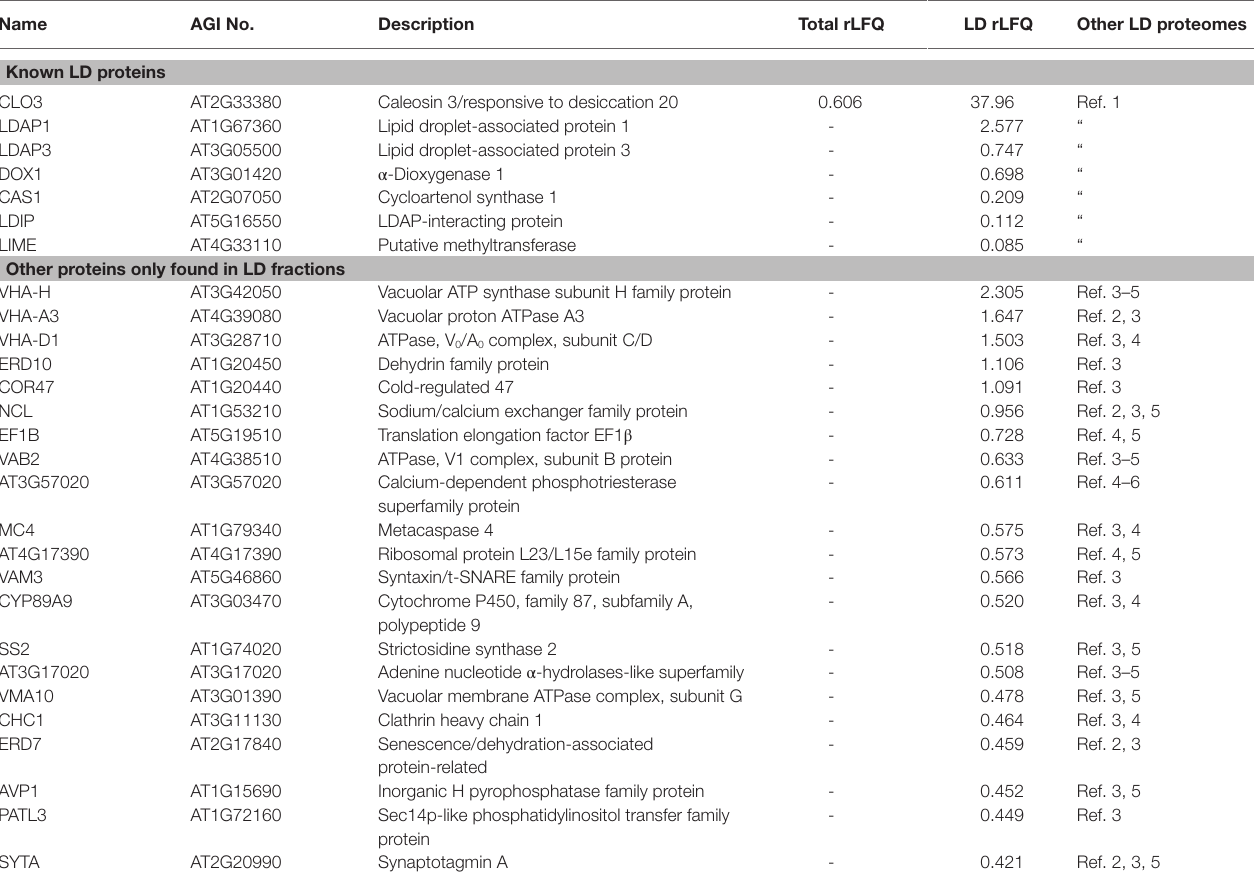
TABLE 1 | Known and candidate lipid droplet (LD) proteins enriched or only detected in LD fractions isolated from drought-stressed Arabidopsis leaves. Name AGI